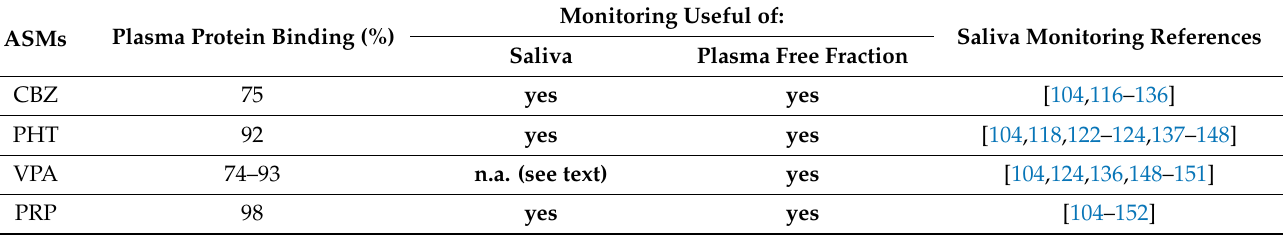
Table 2. Comparison between saliva and plasma free fraction